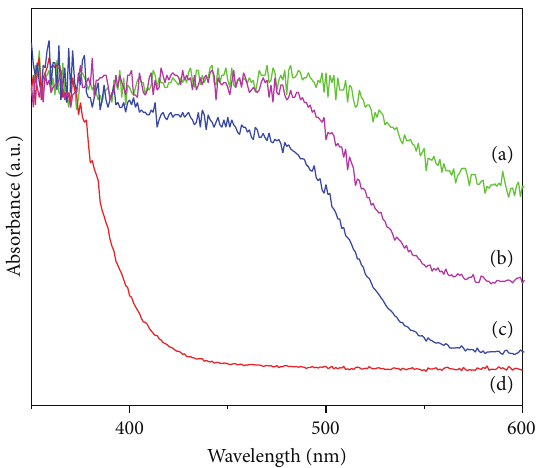
Figure 8: UV-Vis absorption spectrum of samples prepared at 120 ∘ C with CdS contents at 0, 10%, 20%, and 50%.